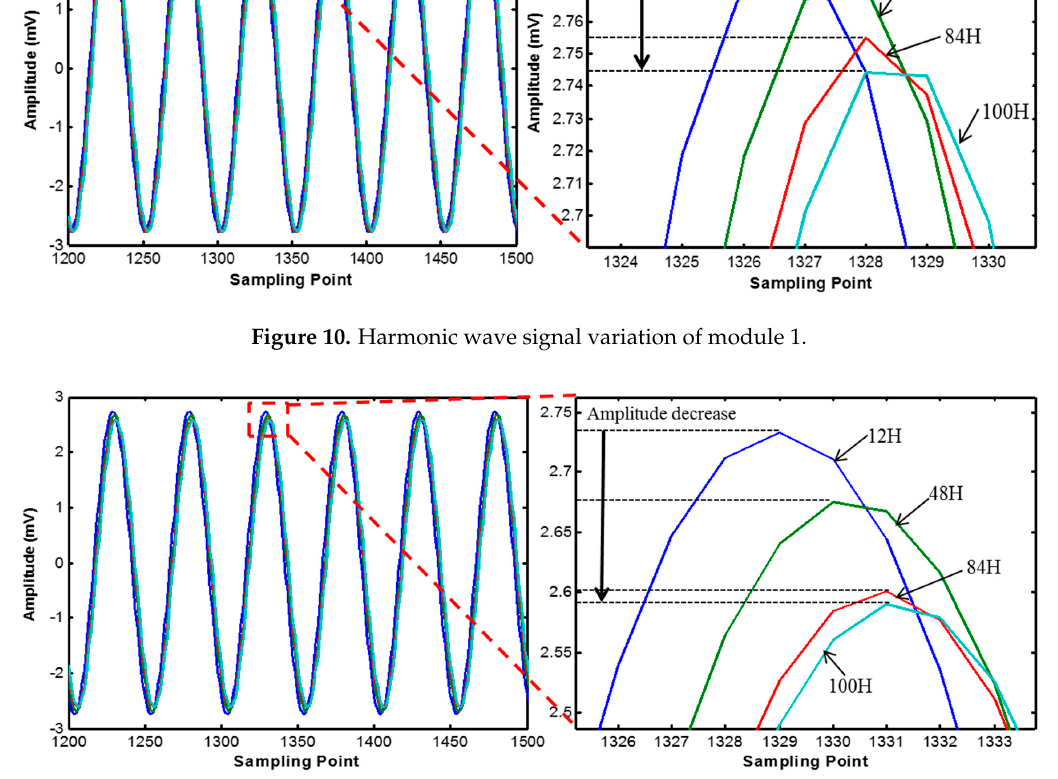
Figure 11. Harmonic wave signal variation of module 2.